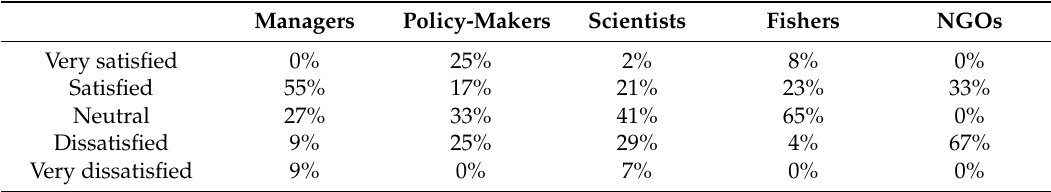
Table 2. Satisfaction among the responding groups regarding results of the implementation of EBFM (% within each responding group. n = 104).